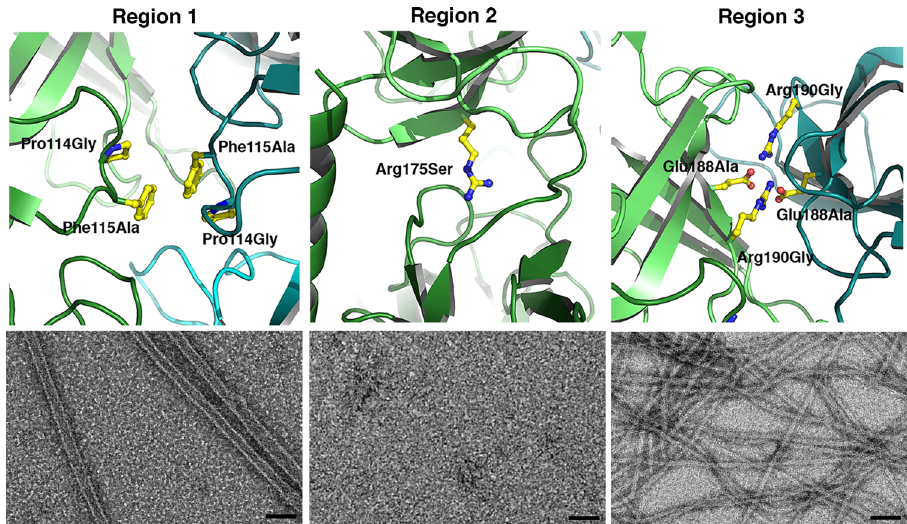
Fig. 3 Lateral and longitudinal interactions play key roles in MreC association. (left) MreC Pa-Region1 is able to form tube-like structures that resemble MreC Pa(36-330) (4 grids, 42 images). (center) MreC Pa-Region2 does not generate any large oligomeric forms that can be visualized by negative-staining EM (4 grids, 39 images), and SV-AUC (Supplementary Fig. 7) indicates a sedimentation pro fi le that is indicative of a much smaller species. (right) MreC Pa- fi bers that are distinct from those observed for MreC Pa(36-330) (9 grids, 80 images). Scale bars in EM images correspond to 50 Region3 forms thin